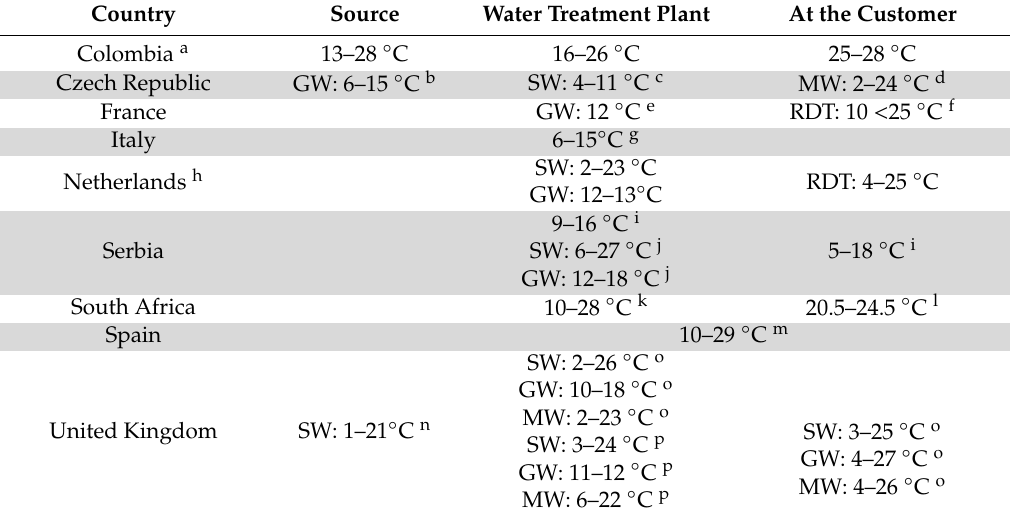
Table 1. Overview of recorded temperatures SW = surface water, GW = ground water, MW = Mix of GW and SW, RDT: Random Day